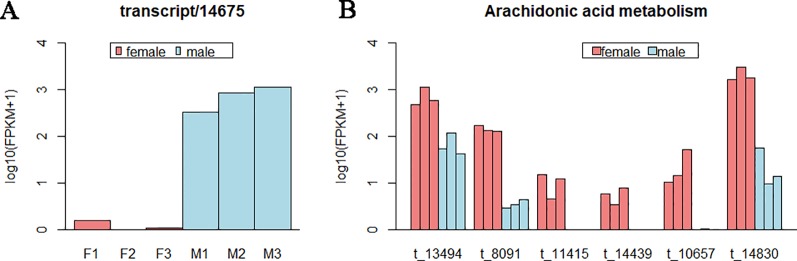
The expression level of some differentially expressed transcripts (DETs) in gonad. (A) Expression level of the DET (transcript/14,675) shared by pathways of Fc gamma R-mediated phagocytosis, Ras signaling pathway, cyclic adenosine 3,5-monophosphate signaling pathway, and choline metabolism in cancer. (B) Expression level of DETs in the pathway of arachidonic acid metabolism. Each bar represents one sample. Different colors indicate different sexes. The abscissa represents the transcript ID. The ordinate represents the logarithm of the (FPKM+1).